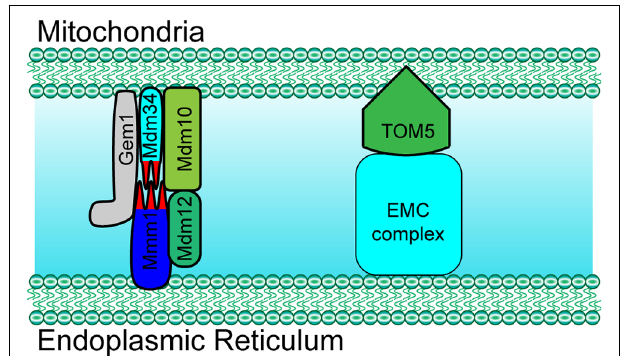
FIGURE 1 | Paradigm of molecular determinants in endoplasmic reticulum (ER)-mitochondria tethering in yeast. Mdm10, Mdm34 and Gem1 located at the outer mitochondrial membrane (OMM) mediate ER-mitochondria tethering by forming a complex with ER membrane located proteins Mmm1 and cytosol Mdm12 in yeast. ER membrane protein complex (EMC) mediates ER-mitochondria contact by interacting with TOM5 at the mitochondrial OMM in yeast. Mdm10/34, mitochondrial distribution and morphology protein 10/34; Gem1, mitochondrial Rho GTPase 1; TOM5, translocase of outer membrane 5 kDa